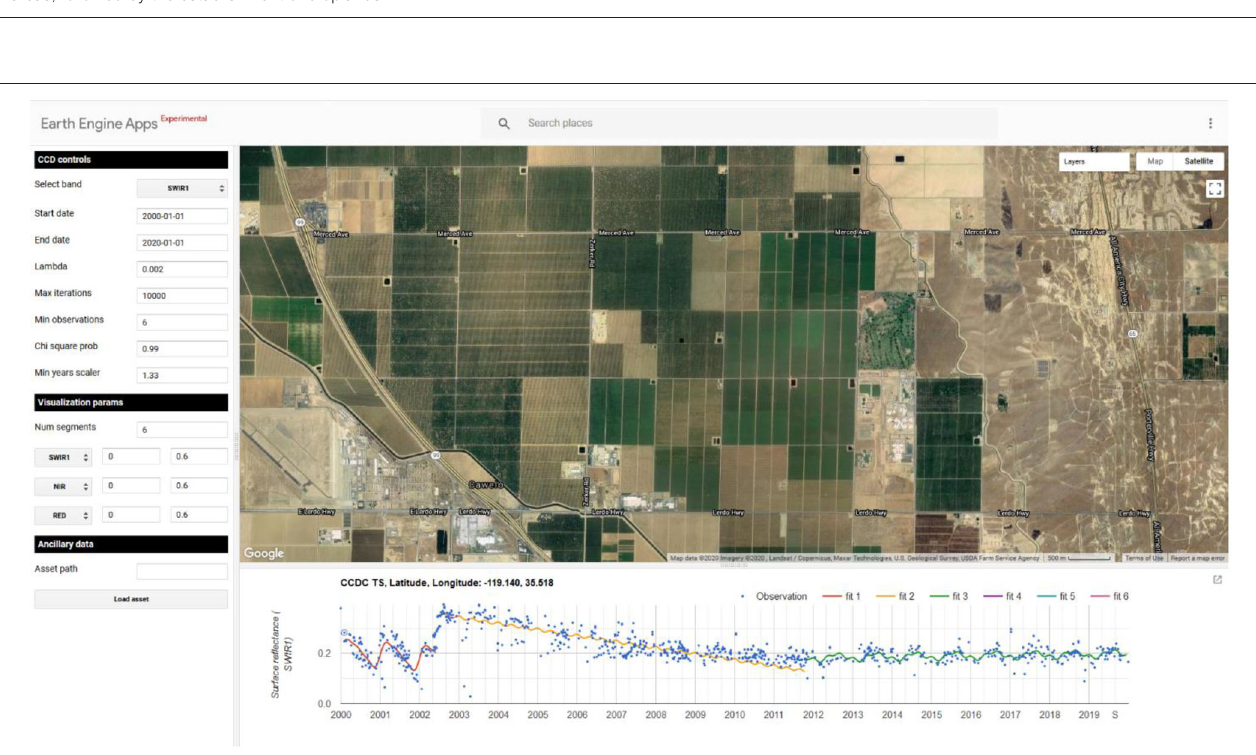
FIGURE 4 | Screenshot of the Advanced time series tool showing the controls in the left panel. The time series of the clicked pixel represents long term agricultural cycles in California.